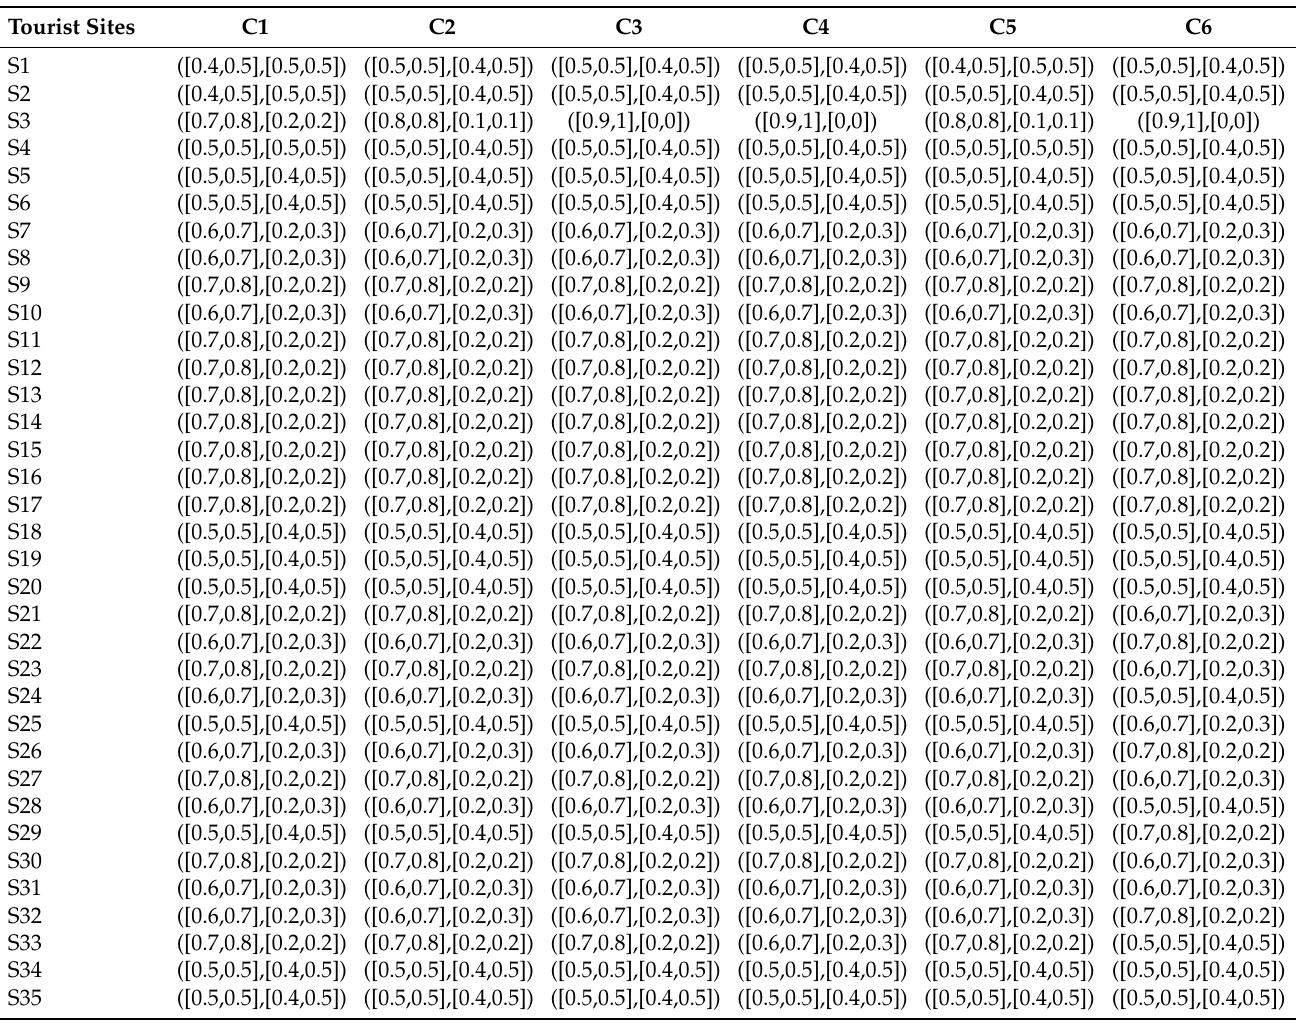
Table 7 illustrates the resulting crisp dataset for the evaluation of tourist sites. Table 4. Sample IVIF dataset representing a respondent evaluating the tourist sites.